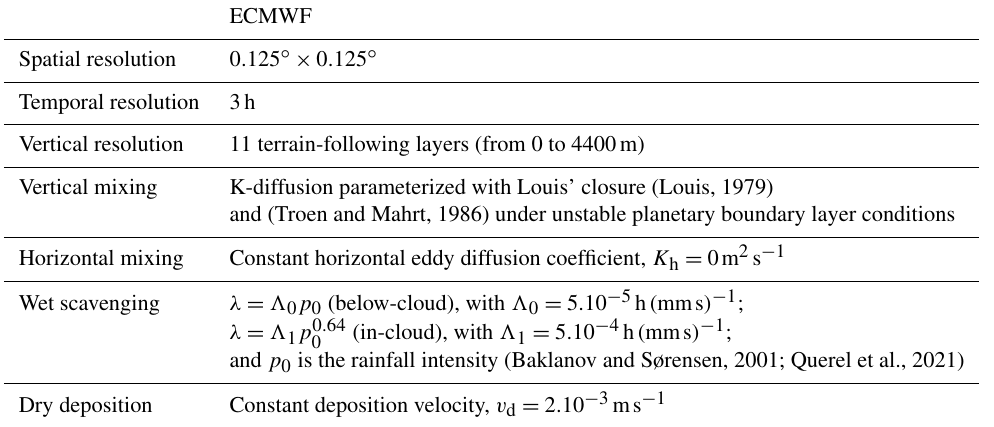
Table 1. Main set-up parameterizations of the ldX 137 Cs transport simulations. The spatial and temporal resolutions are those of the ECMWF meteorological fields and the transport model. The other entries correspond to parameters of the transport model